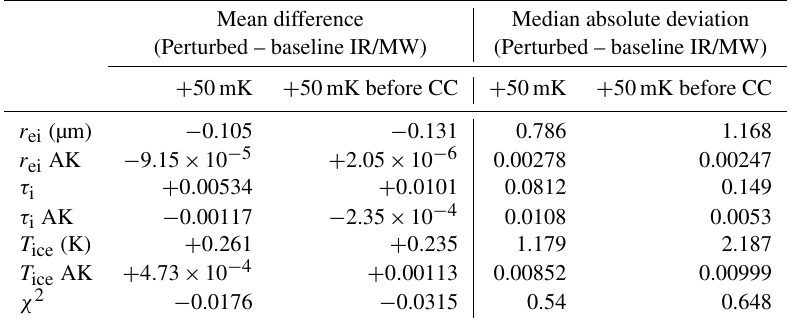
Table 1. The two radiance perturbation tests after cloud clearing ( + 50mK) and before cloud clearing ( + 50mK before CC); see text for description), with reported mean difference and median absolute deviations of cloud properties, AKs, and χ 2 for 54 ◦ S–54 ◦ N, over ocean,